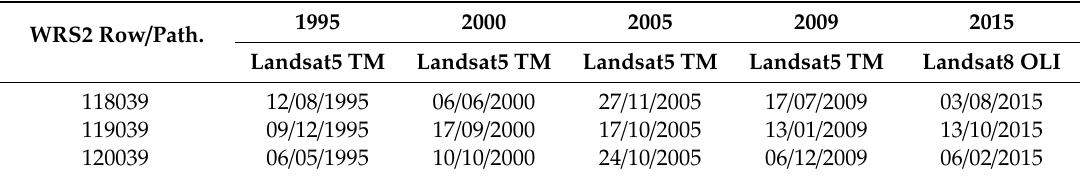
Table 1. Acquisition date of the image